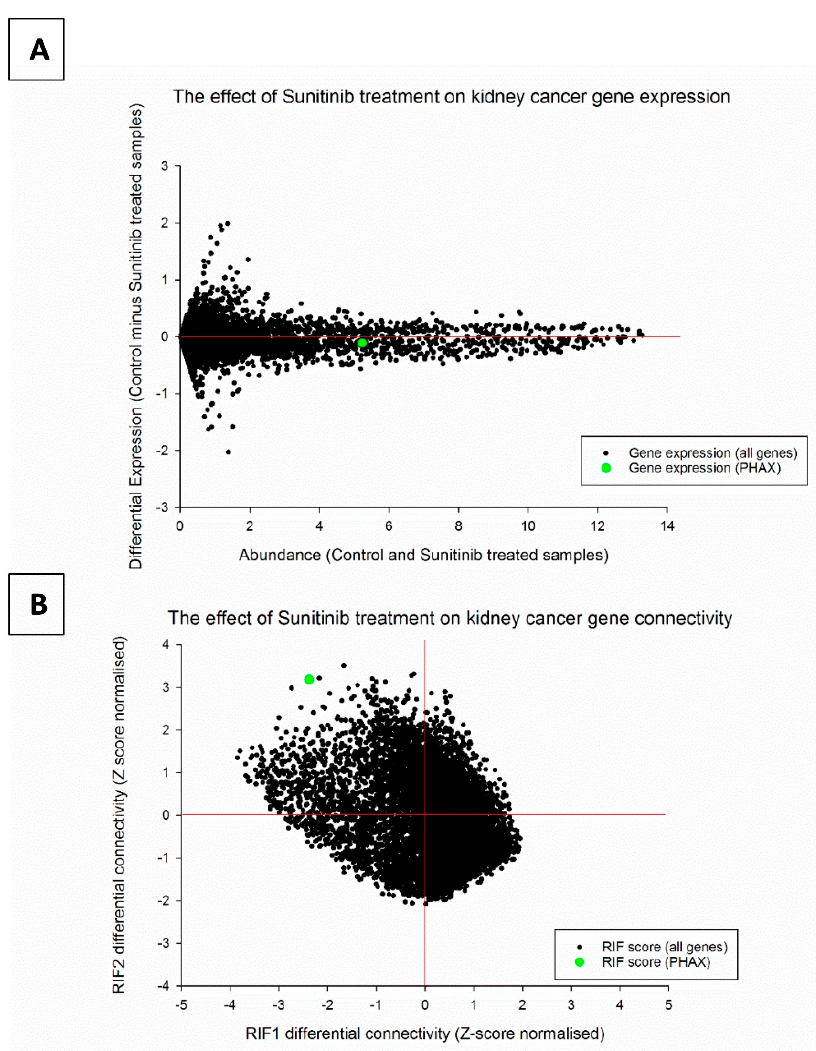
Figure 1. PHAX mRNA expression in samples of renal cell cancer (RCC) tissue from patients with metastatic RCC (mRCC) either treated with sunitinib or untreated controls patients. PHAX mRNA is moderately abundant and not di ff erentially expressed across the two treatment groups ( A ). However, we found using the regulatory impact factor (RIF) algorithm that PHAX mRNA is highly di ff erentially connected between networks constructed using the two groups ( B ). The extreme RIF score for di ff erential networking implies that the encoded protein PHAX behaves very di ff erently in the drug treated versus control samples even though its own mRNA expression level has remained largely